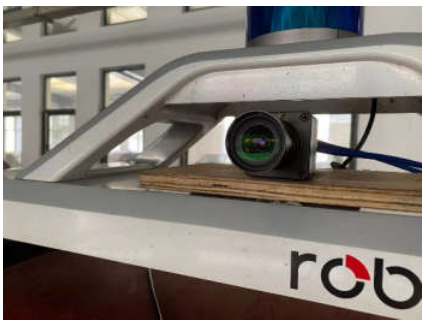
Figure 14. Test vehicle.